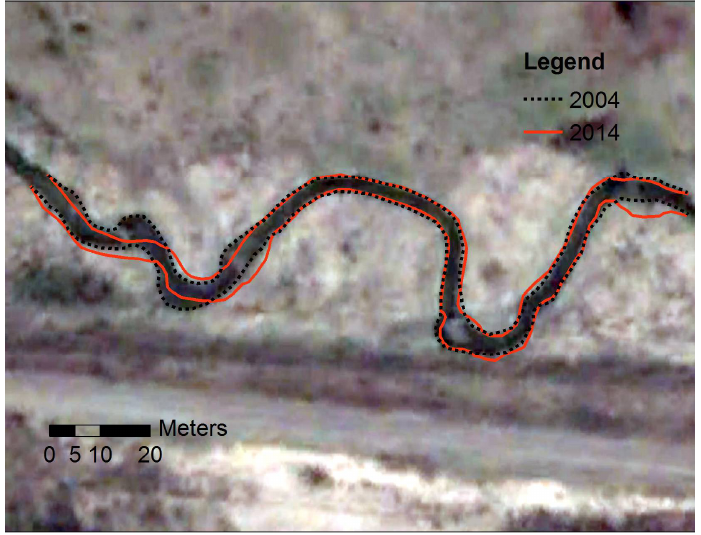
Figure 7. Channel margin migration along the M4 sampling reach. Flow from left (west) to right (east). Background image adopted from Google Earth image (2004).